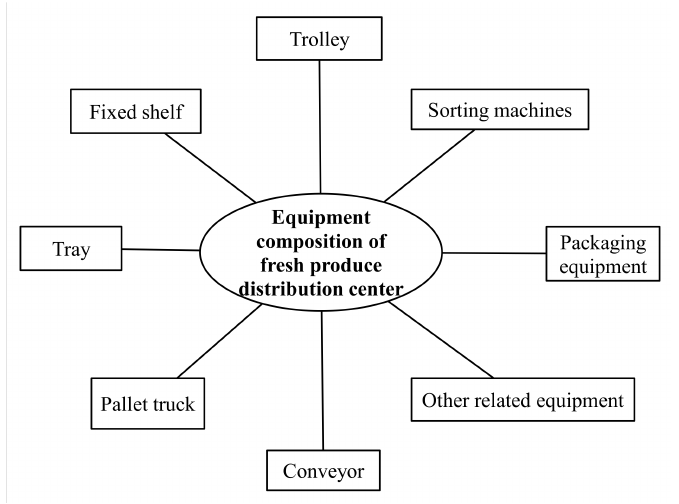
Figure 4. Organization management system.